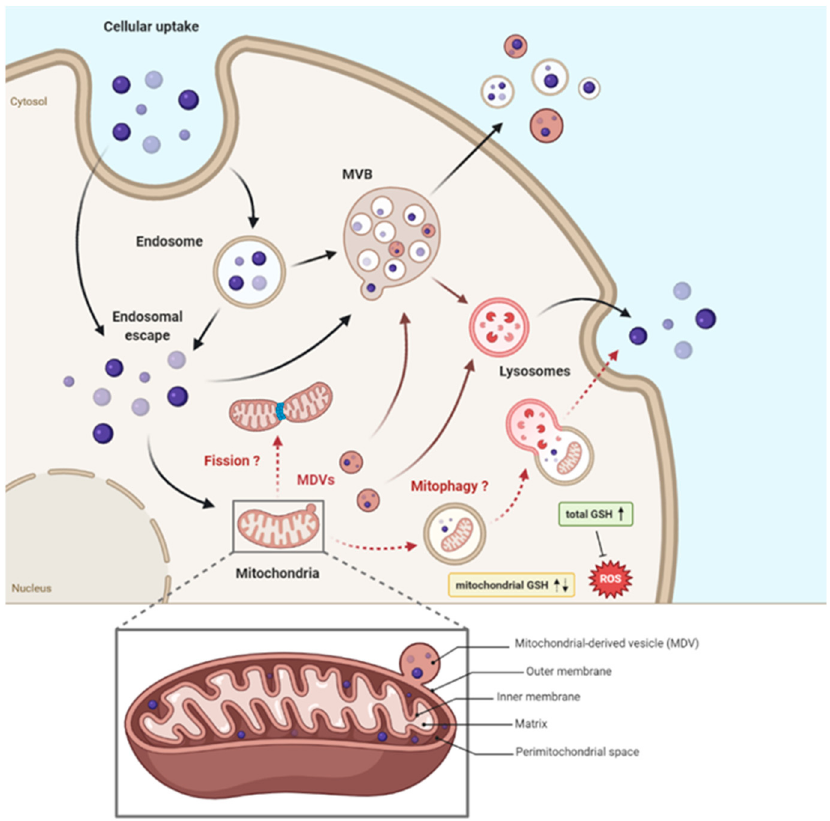
Figure 5. Schematic representation of SiNPs uptake in U937 cells and their intracellular trafficking, by highlighting the effects on mitochondria. Our previous data [1] showed a colocalization with both lysosomes and mitochondria in U937 cells, indicating intracellular endocytic rehashing of SiNPs once inside the cells and transport to other organelles. Confocal analysis depicted the peripheral distribution of SiNPs, located in the peri-mitochondrial space (as illustrated in the enlargement of the mitochondrion). Flow cytometric data of entire cells and isolated mitochondria suggested the mitophagic process to eliminate damaged mitochondria full of SiNPs or either mitochondrial fission and/or mitochondrial-derived vesicles (MDVs) budding from mitochondrial outer membranes to free mitochondria from SiNPs. Although an initial ROS overexpression was detected, mitochondrial respiration was not substantially impaired. After 1 h, cells maintain the ability to synthesize GSH in the cytosol and its transport to mitochondria is not compromised, as we observed a higher amount of GSH in comparison to controls. Nevertheless, after 24 h of incubation with SiNPs, while total GSH is still higher than control cells in order to buffer ROS, mitochondrial GSH is slightly reduced. Finally, cells are able to release SiNPs both with vesicle or non-vesicle related secretion. (Image created with BioRender.com, accessed on 31 December 2020).